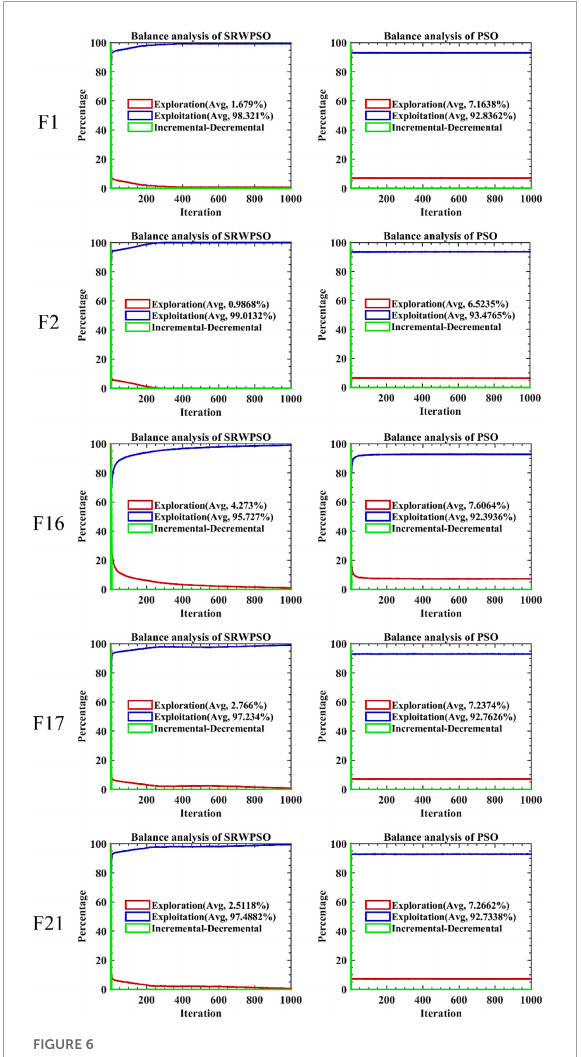
FIGURE6 The balance analysis results of SRWPSO and PSO.